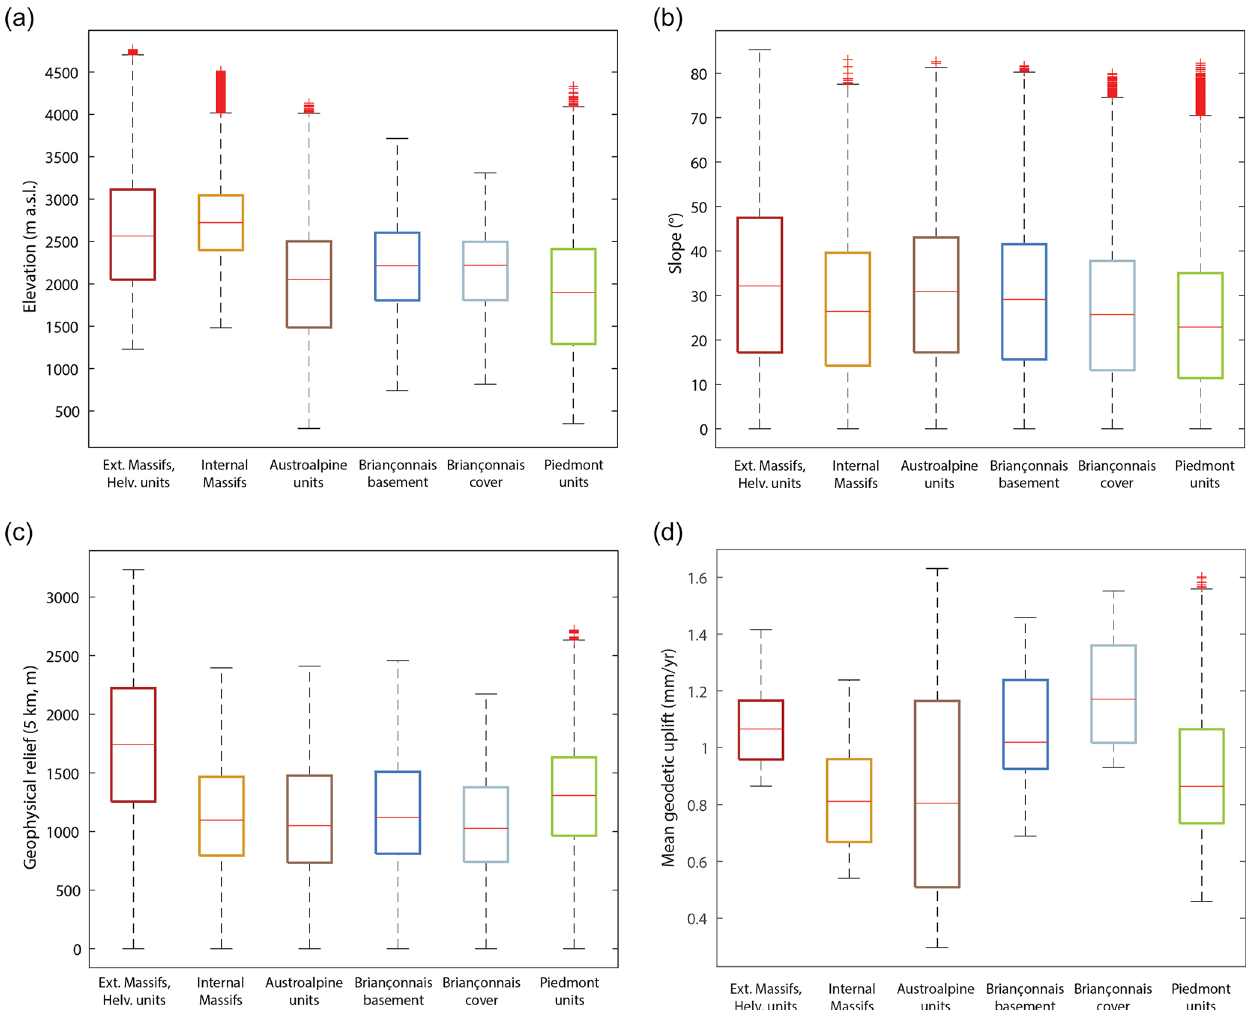
Figure 7. Box-and-whisker plots for the spatial distribution of elevation (a) , slope (b) , 5km geophysical relief (d) and mean geodetic uplift (d) within the entire DB catchment, classified by individual lithotectonic unit. The horizontal red line represents the median of each distribution; bottom and top of each box are the 25th and 75th percentiles. Whiskers extend up to 1.5 times the interquartile range; outliers (red crosses) are observations beyond the